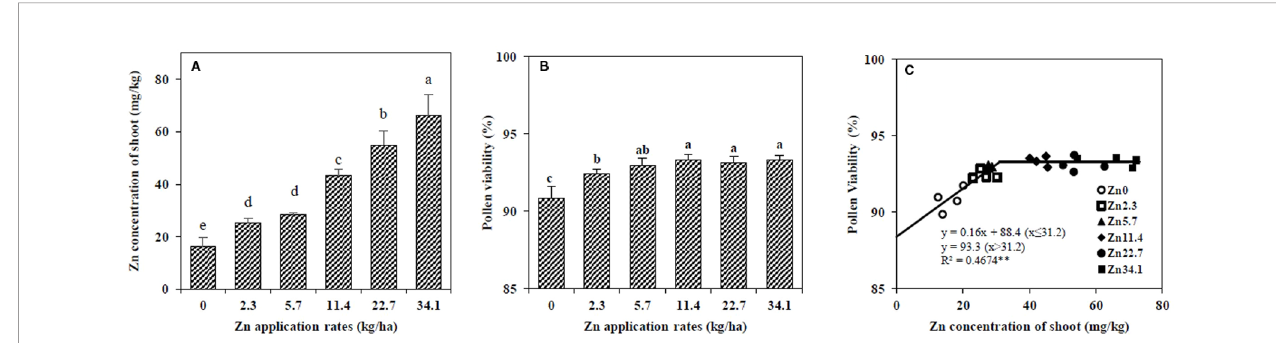
FIGURE 1 | Effect of Zn application rate on the Zn concentration in the shoot (A) and pollen viability (B) in maize at the tasseling (VT) stage, and the relationship between pollen viability and Zn concentration in the shoot at the VT stage (C) . The pollen viability was scored according to staining level (pollen with bold red colour as viable and colourless as nonviable). The percentage of pollen viability was determined as the ratio of the number of viable (energetic) pollens to the total pollens number. Values are the average ± SE of four replicates. Means with the same letters are not signi fi cantly different at P < 0.05 according to Fisher ’ s least signi fi cant difference (LSD) test. ** P <